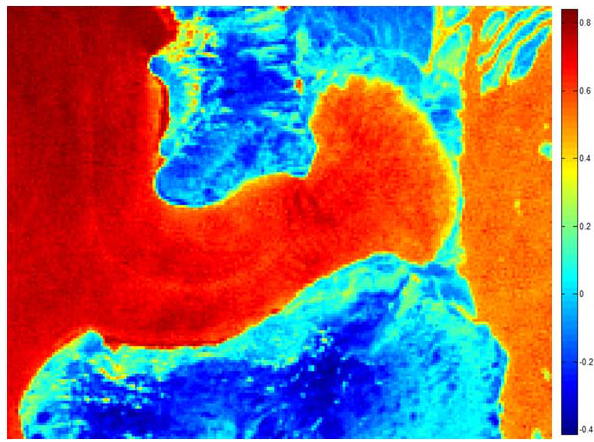
Figure 3. Normalized Difference Snow Index map derived from Landsat TM image.